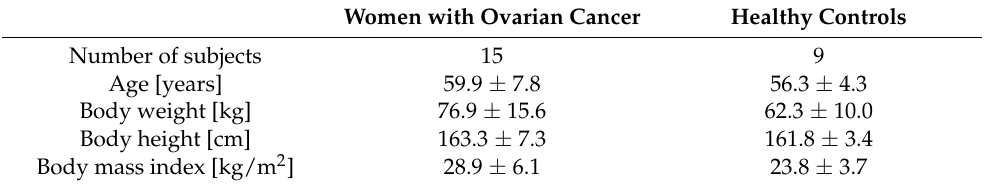
Table 1. Characteristics of the investigated women (arithmetic mean ± standard